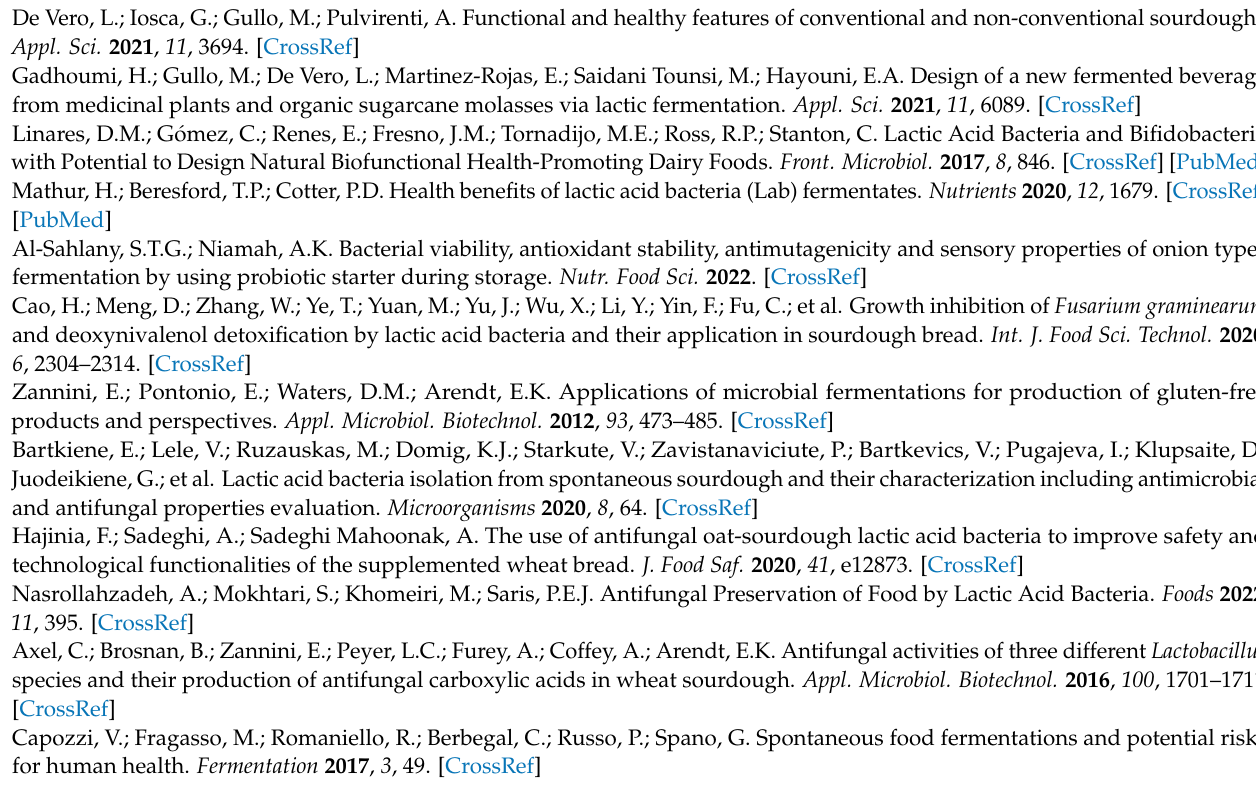
Figure S7: MS spectrum ( a ) and MS/MS spectrum ( b ) for the sample obtained from Leuconostoc citreum UMCC